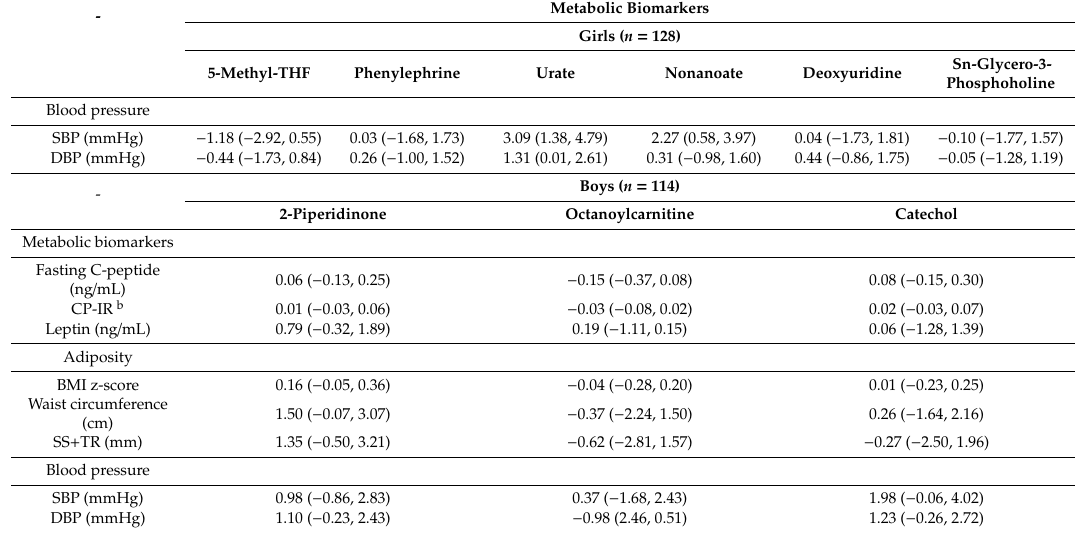
Table 4. Associations of quartiles of SSB-related metabolites with blood pressure in ELEMENT participants during